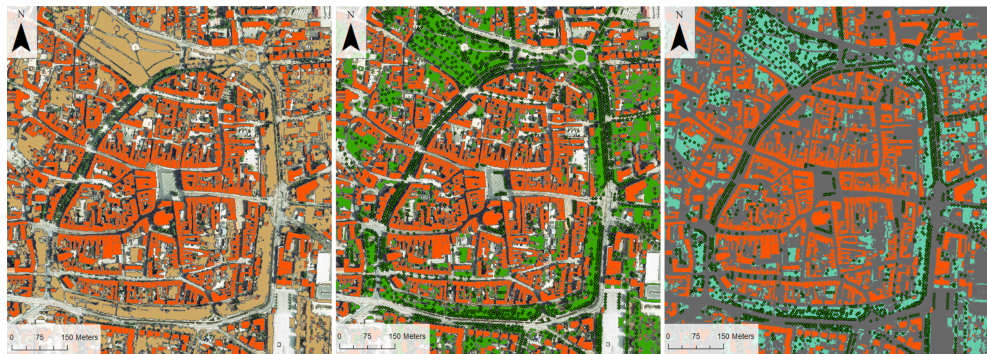
Figure 2. Schematic visualisation of the climate adaptation scenarios: These include the removal of all vegetation in the study area leading to bare soil surfaces ( left panel), an increase of albedo for sealed surfaces ( middle panel), and an increase in soil humidity ( right